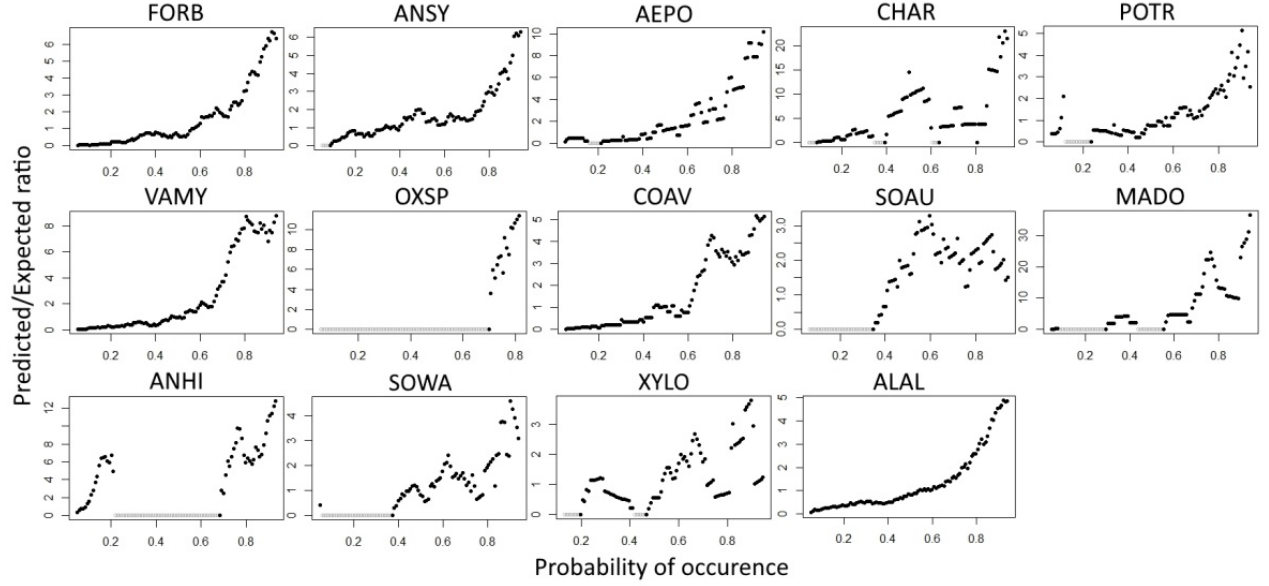
Figure 4. Continuous Boyce index plots for 14 food-probability models for the brown bear in the Central Forest State Nature Reserve (West-European Russia) in 2008–2020. FORB— Apiaceae spp.,